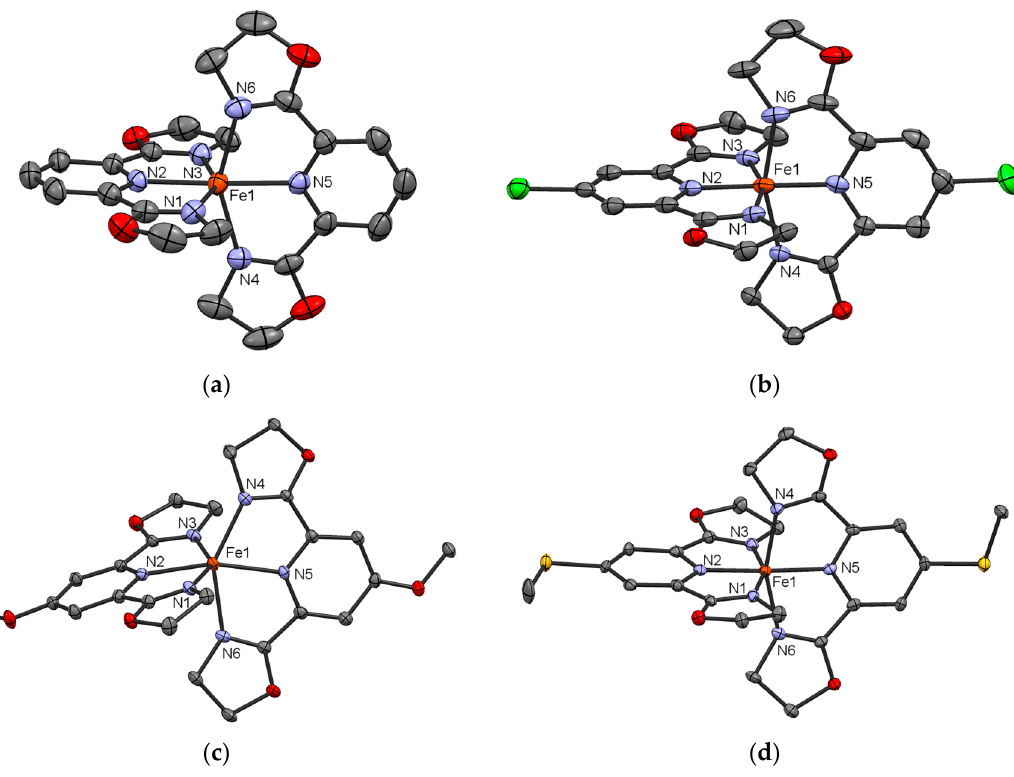
Figure 1. X-ray crystal structures of [Fe(X-pybox) 2 ](ClO 4 ) 2 for X = ( a ) H (400 K); ( b ) Cl (100 K); ( c ) CH 3 O (100 K); and ( d ) CH 3 S (100 K). The thermal ellipsoids are drawn at the 20%, 50%, 50%, and 50% probability levels, respectively. Hydrogen atoms and counter anions are omitted for clarity.